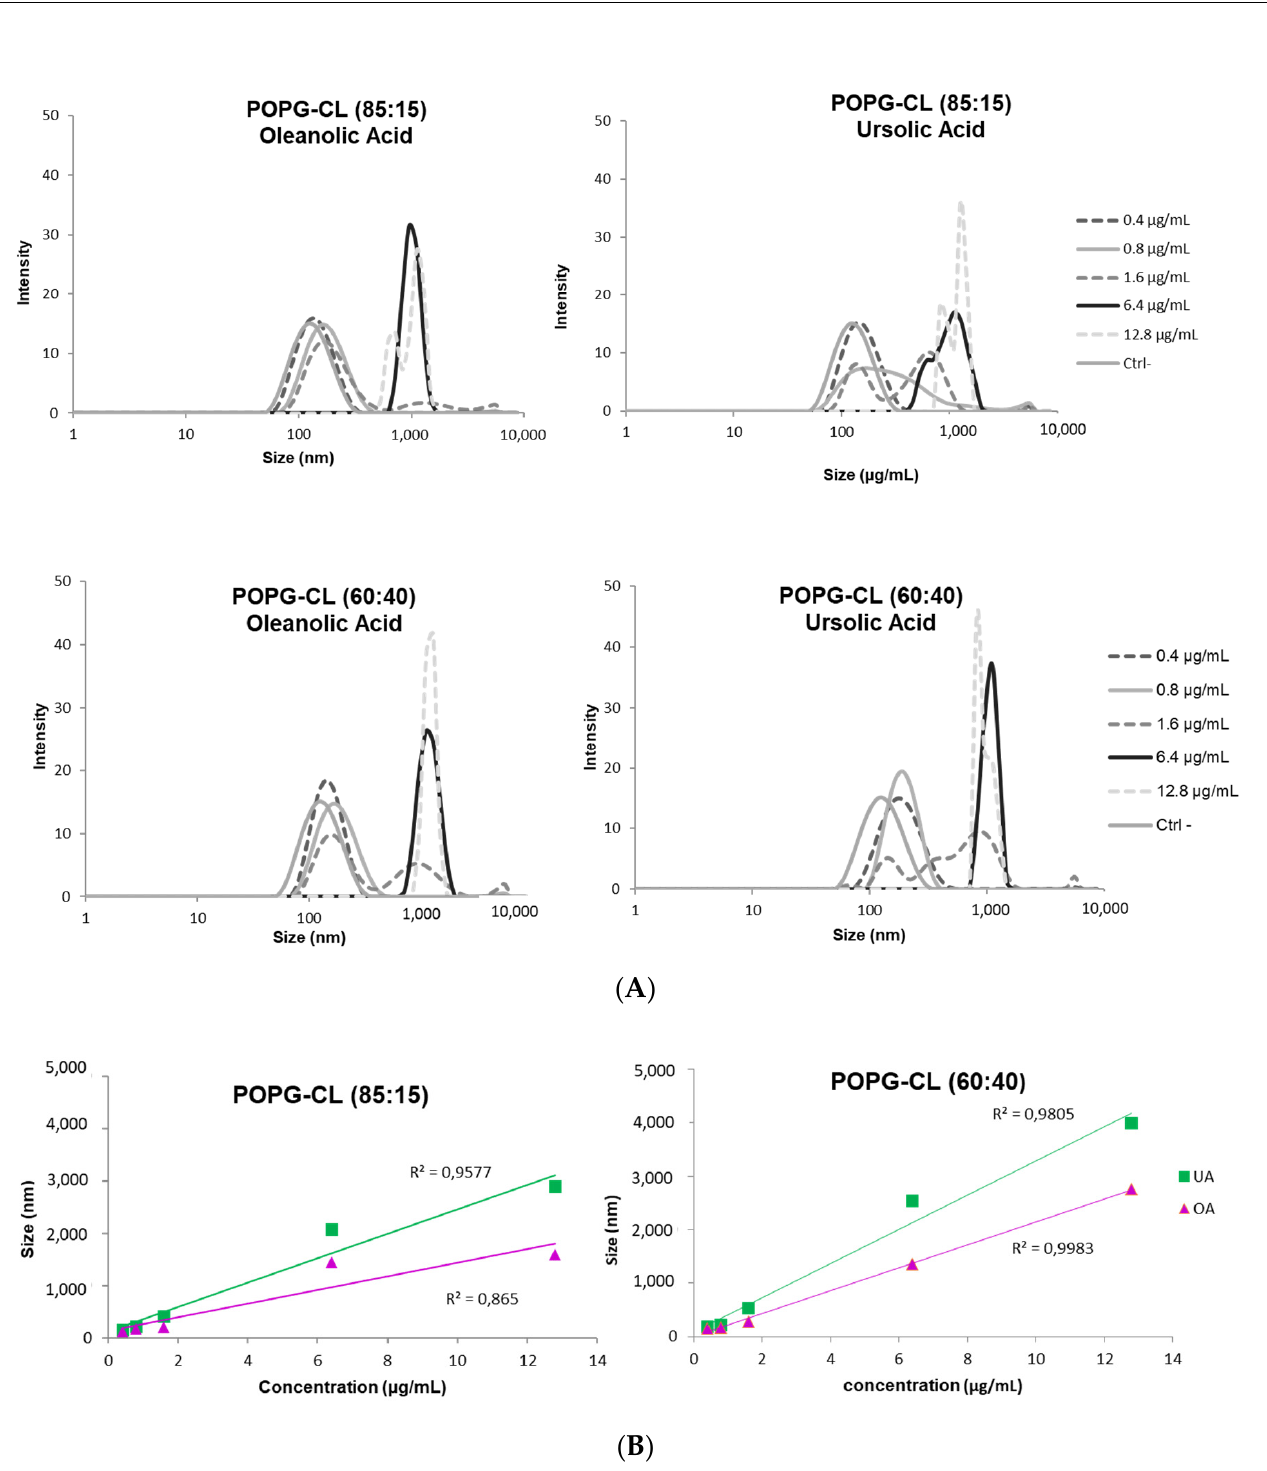
Figure 6. Effect of UA (Ursolic acid) and OA (Oleanolic acid) on LUV size in lipid vesicles (POPG:CL, 85:15 ( top ) or POPG:CL, 60:40 ( bottom )) ( A ) Effect of UA and OA concentrations on liposome size; ( B ) POPG (1-Palmitoyl-2-oleoyl- sn - glycero-3-phosphoglycerol), CL (cardiolipin).